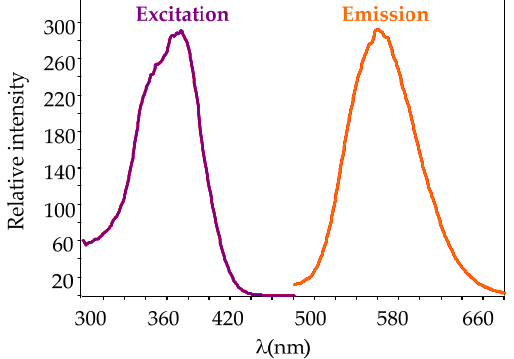
Figure 17. Spectrum of the Al-Ferron sensor in sol–gel support.